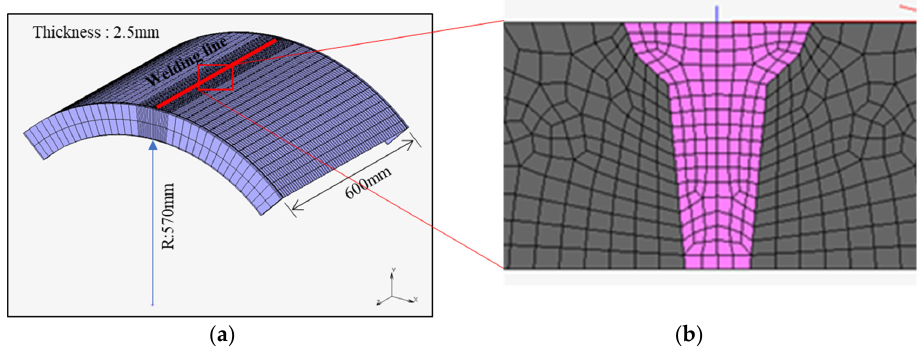
Figure 1. Analysis model: ( a ) Shape and dimension of model; ( b ) mesh shape [27].